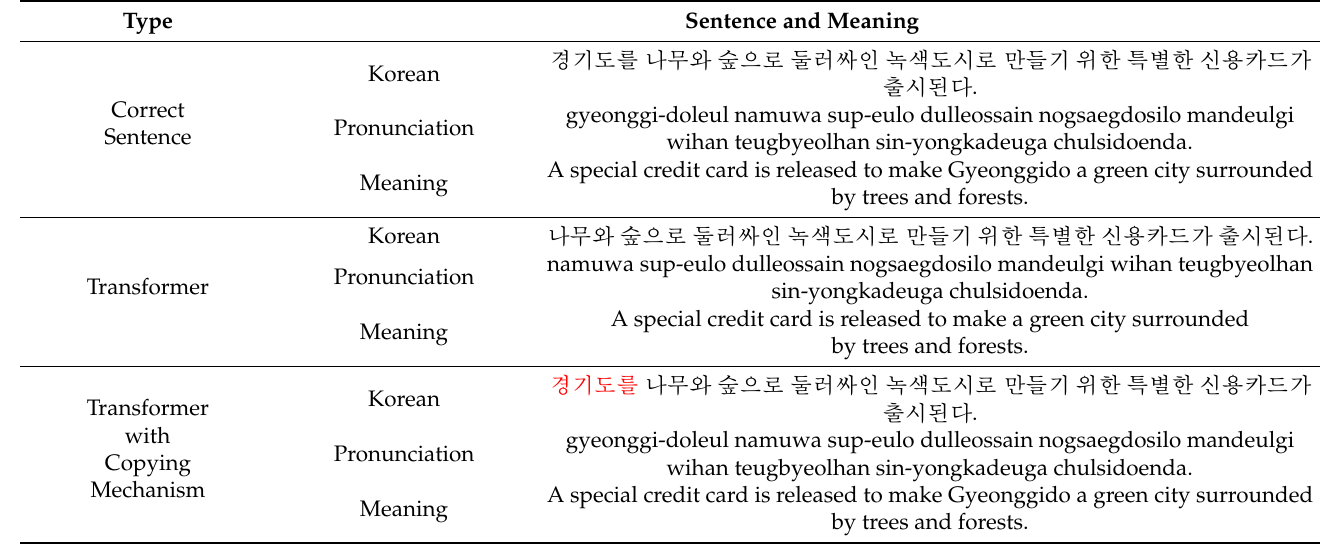
Table 13. Example of Output Comparison of Transformer and Transformer with Copying Mechanism for the Correct